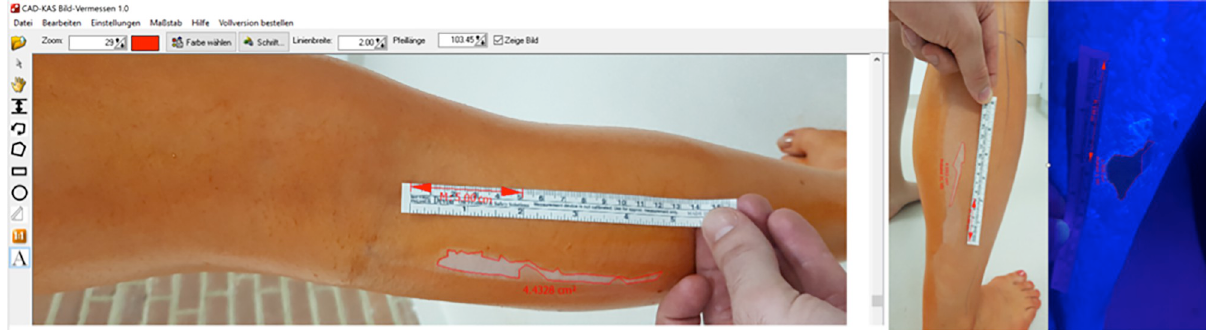
Fig 3. Figure demonstrating the areas missed and marked out through the use of the CAD-KAS